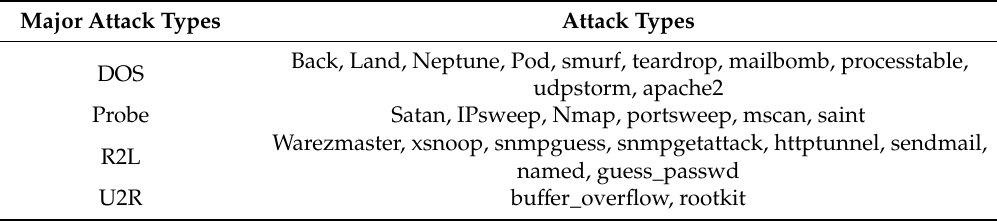
Table 2. Attack types on sub dataset of Test +